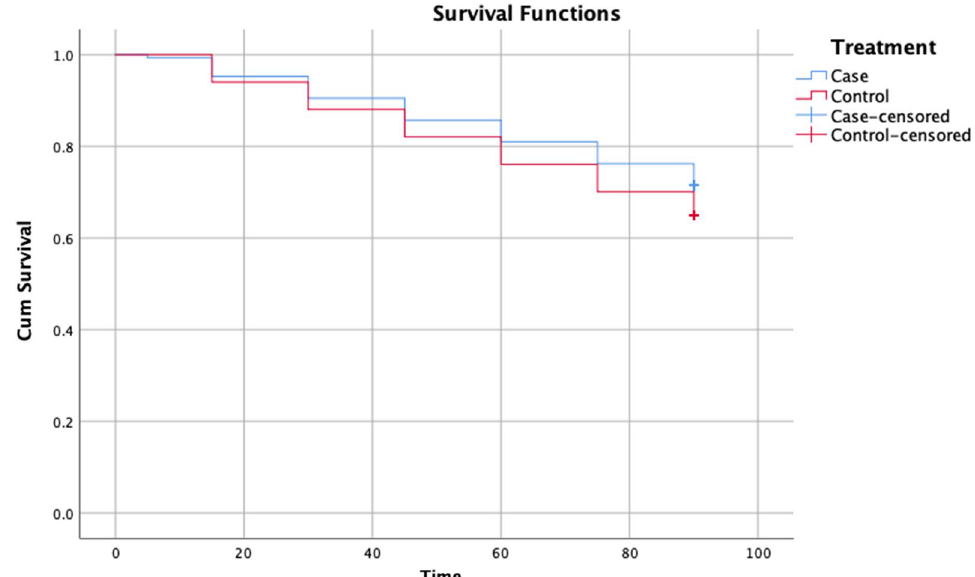
Fig. 2 Kaplan–Meier curves for survival free of major adverse cardiovascular events (MACE) in case and control groups